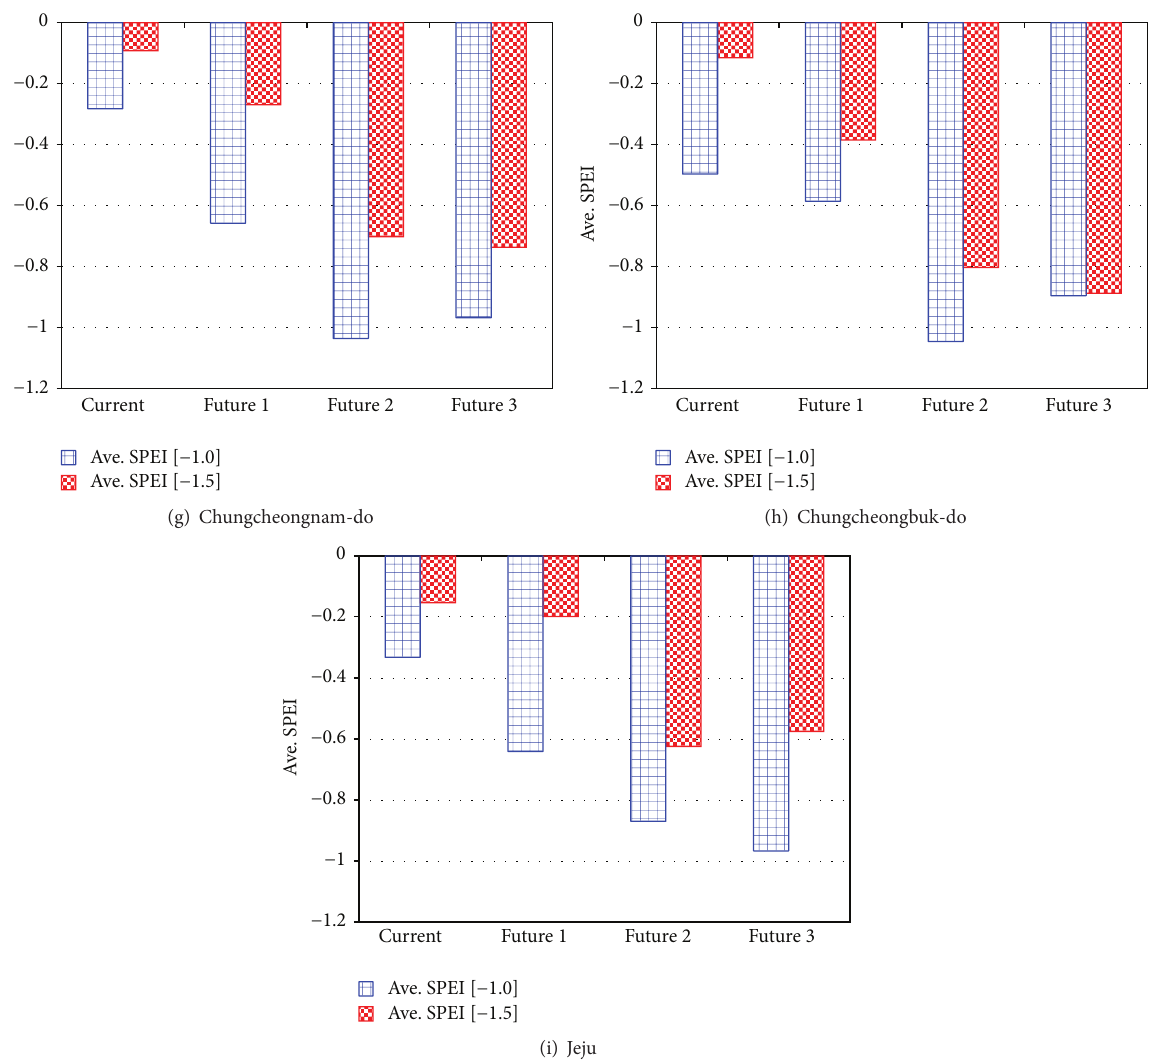
Figure 12: Change in drought magnitude in the current and future